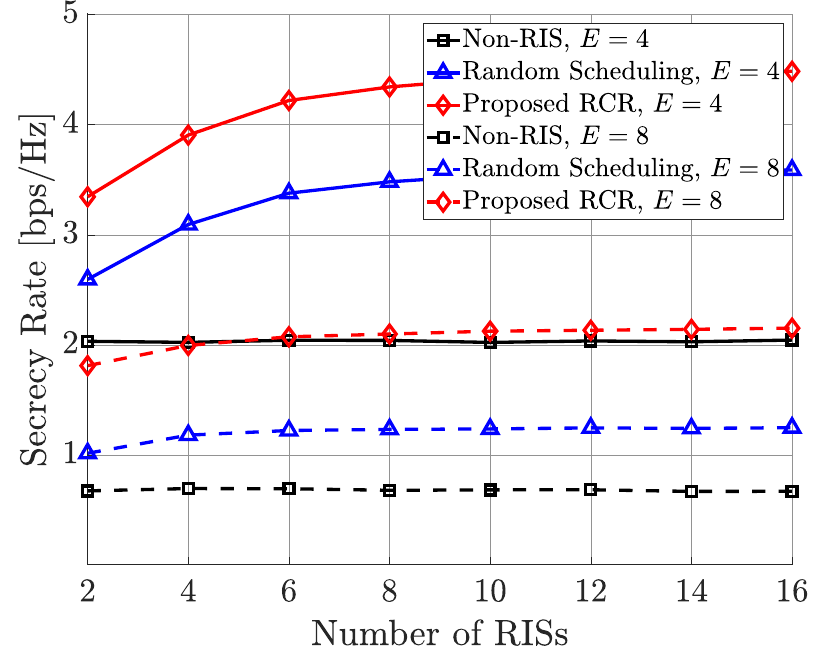
Figure 5. Secrecy rate performance according to number of